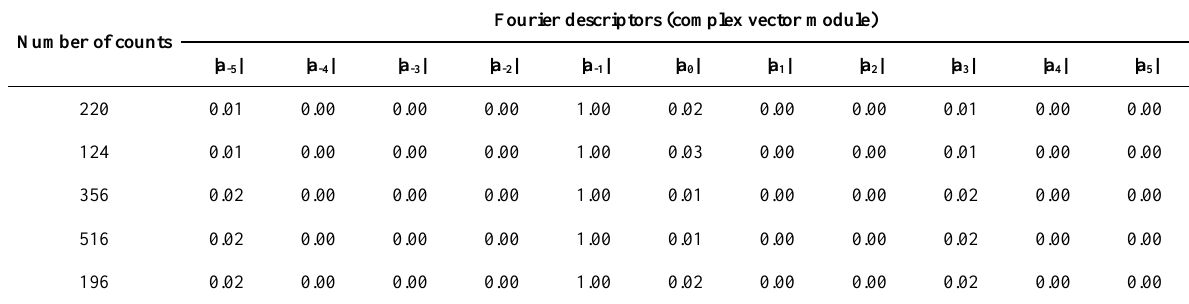
Table 2. Normalized Fourier descriptors of contours of different